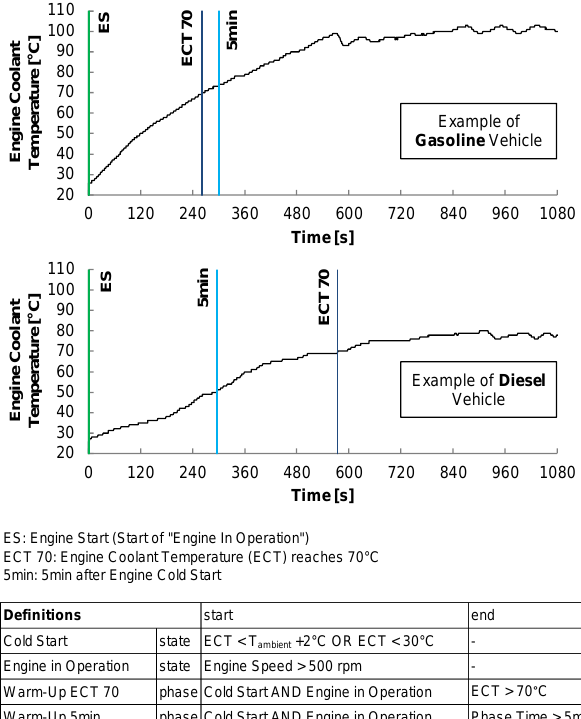
vehicle) Displa- Exhaust Aftertreatment cement System